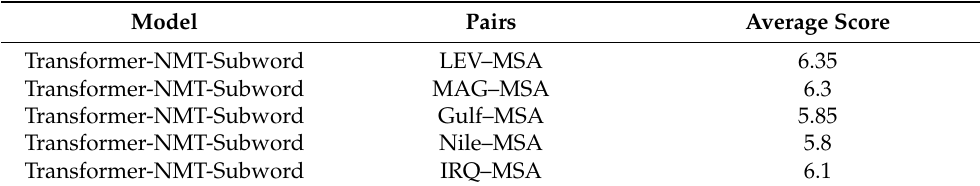
Table 9. Human Evaluation Scores -Pilot Rating Experiments (PRE).